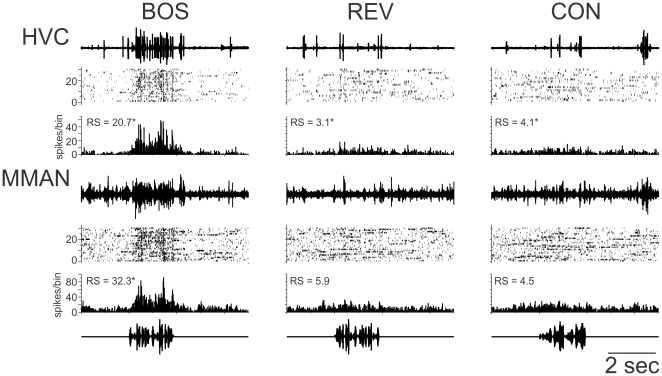
Auditory-evoked action potential activity in MMAN and HVC.Simultaneous multiunit activity from ipsilateral MMAN and HVC in response to playback of the bird's own song (BOS), the BOS in reverse (REV), and conspecific (CON) song. For both HVC and MMAN, top row, raw data for a single playback of each song; middle row, raster plot of activity to thirty iterations of each song; bottom row, peri-stimulus time histogram (PSTH) of the cumulative response to each song playback. Bin size = 25 ms. The response strength (RS) for each response is given, * indicates a RS that was significantly greater than 0 (one-tailed t-test; p<0.05). For MMAN response to REV, p = 0.06; CON, p = 0.08.